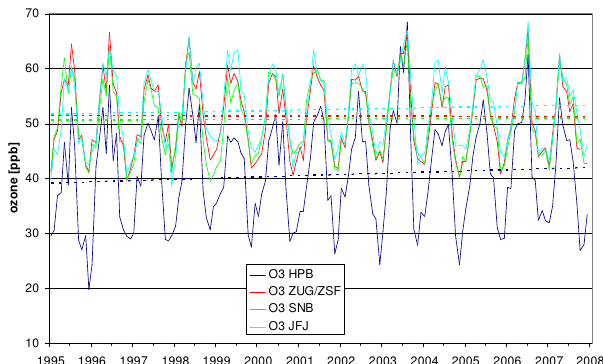
Fig. 3. O 3 mean annual variation (1995–2007) at the respective “DACH” sites; blue: HPB; red: ZUG/ZSF, light blue: JFJ, green: 3 mean annual variation (1995-2007) at the respective „DACH“ sites; blue: HPB; 4 red: ZUG/ZSF, light blue: JFJ, green: SNB. 5